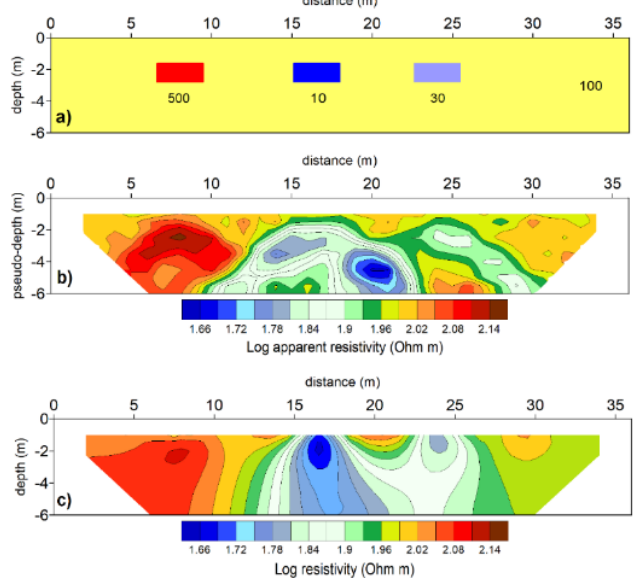
Figure 2. A synthetic test: ( a ) assigned 2D three ‐ prism model, ( b ) simulated pseudosection, ( c ) model reconstruction by the original PERTI